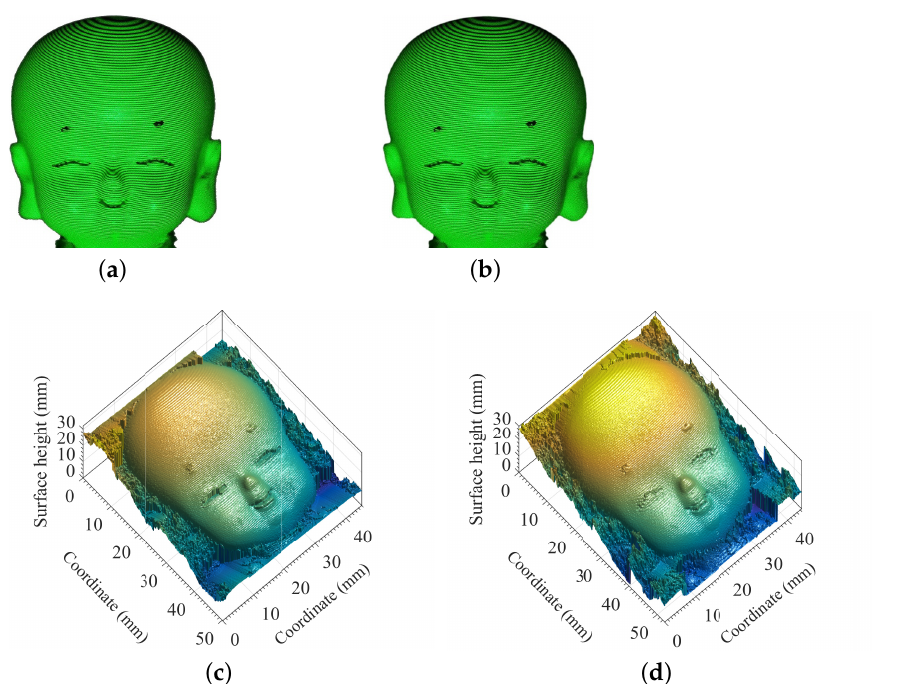
Figure 8. Human-head-model retrieval as background illuminance E = 0 Lux for indoor measure- ment. ( a ) without filtering; ( b ) with filtering; ( c ) retrieval using the image of ( a ); ( d ) retrieval using the image of ( b ).